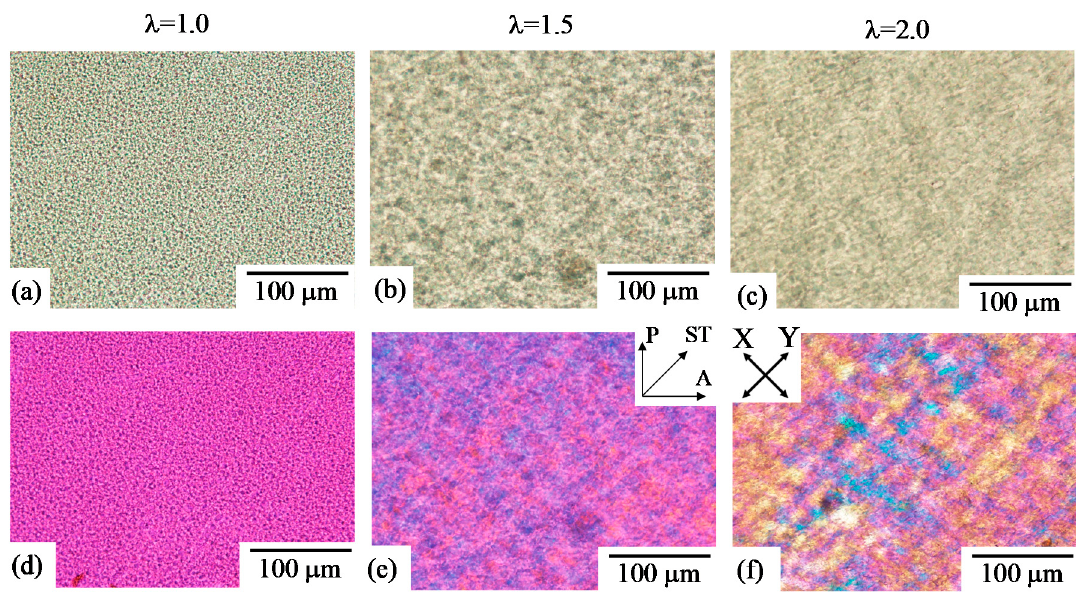
Figure 5. Unpolarized and polarized optical micrographs of 70/30 PC/PMMA obtained by simultaneous biaxial stretching at various draw ratios λ . The upper pictures are optical micrographs, and the lower pictures are polarized optical micrographs. ( a ) λ = 1.0 (unpolarized); ( b ) λ = 1.5 (unpolarized); ( c ) λ = 2.0 (unpolarized); ( d ) λ = 1.0 (polarized); ( e ) λ = 1.5 (polarized); ( f ) λ = 2.0 (polarized).